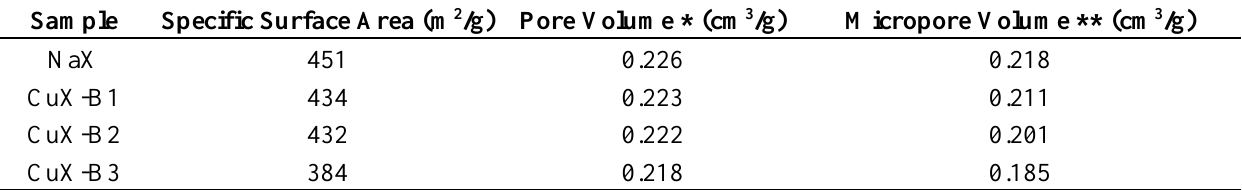
Table 2. Textural properties of the NaX and copper-exchanged zeolites.